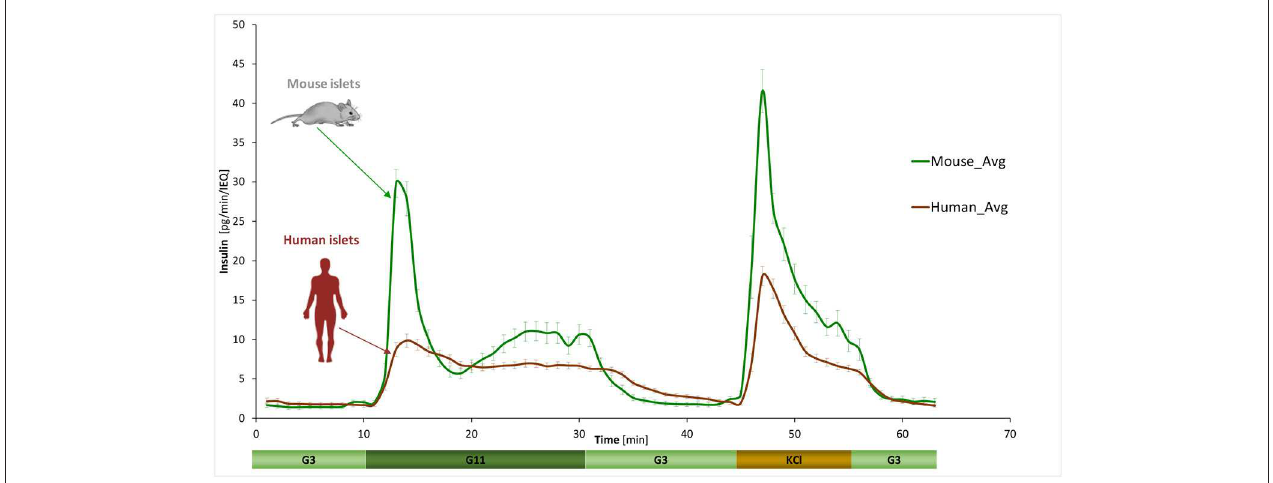
FIGURE 1 | Dynamic GSIS in isolated human and murine islets. Average of all experimental data collected for free murine and human islets perifused using a low (3mM; G3, 8min) → high (11mM; G11, 20min) → low (3mM; G3, 15min) incoming glucose stimulation (plus 10min KCl followed by G3) as shown. Automated PERI4-02 multichannel perifusion apparatus used (samples collected every minute; 0.1 mL/min flow rate, ∼ 100 IEQ per channel). Data are average ± SEM from multiple isolations ( n = 25 and 34 total samples for murine and human, respectively).